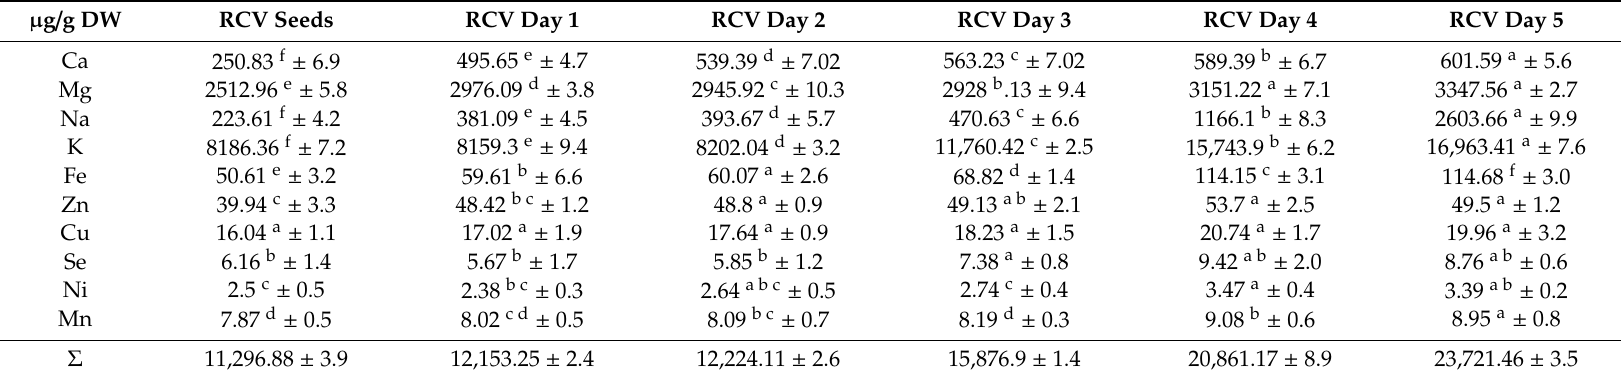
Table 2. Minerals in RCV sprouts in µ g / g DW (dried weight) of vegetal material (RCV sprouts samples were coded as: day 1—first day of germination; day